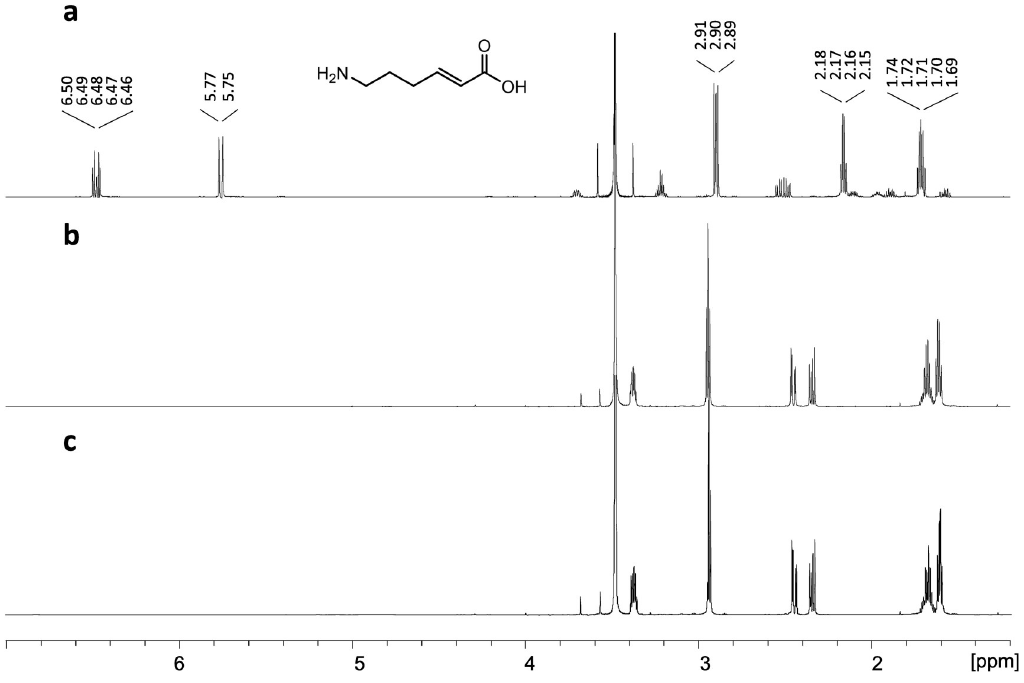
Fig 3. MAL activity on β -lysine monitored using 1 H NMR. (a), Spectrum corresponding to 60 mM 6-AHEA in reaction buffer. (b), Spectrum corresponding to β -lysine incubated with CaMAL at 30˚C for 4 d in reaction buffer. (c), Spectrum corresponding to the control reaction in which β -lysine was incubated in reaction buffer for 4 d at 30˚C.